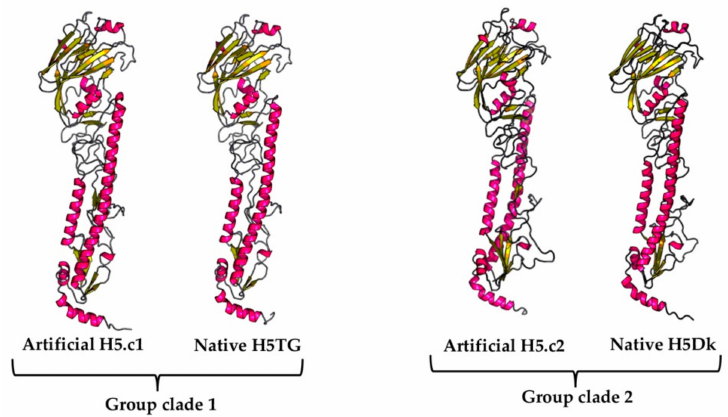
Figure A1. The predicted HA protein structures by